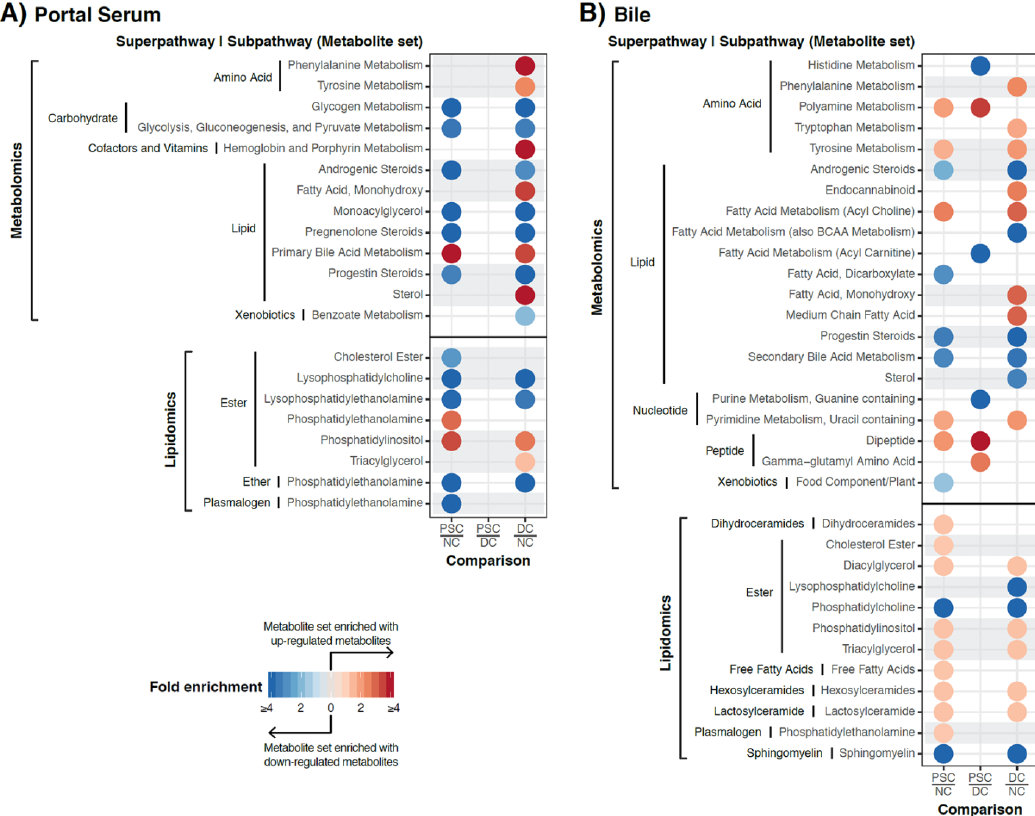
Figure 4. Overview of metabolite set enrichment analysis results for portal serum ( A ) and bile ( B ). Subpathways (i.e., metabolite sets) significantly enriched with up- or downregulated metabolites were identified using a hypergeometric test ( p < 0.05) and shown with circles for the corresponding phenotype comparison. Color reflects the direction of the overall change (red for upregulation and blue for downregulation), while the intensity reflects the degree of enrichment compared to random chance. Subpathways enriched in both portal serum and bile (in at least one of the phenotype comparisons) were highlighted with gray background.